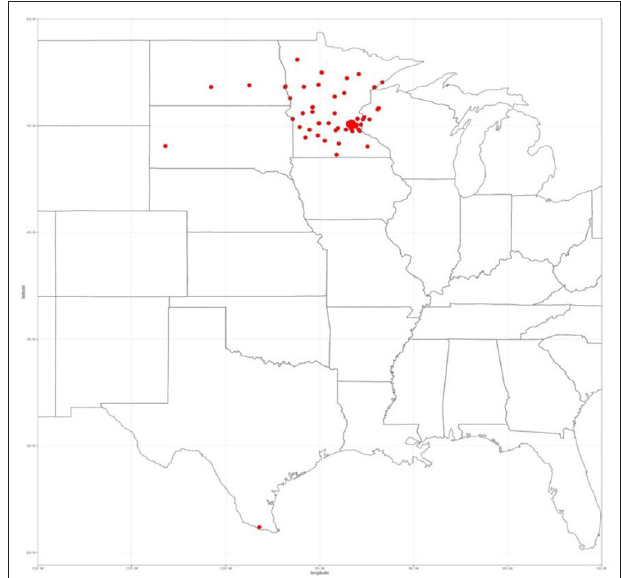
FIGURE 1 | Referral sites of the different locations where the imaging was